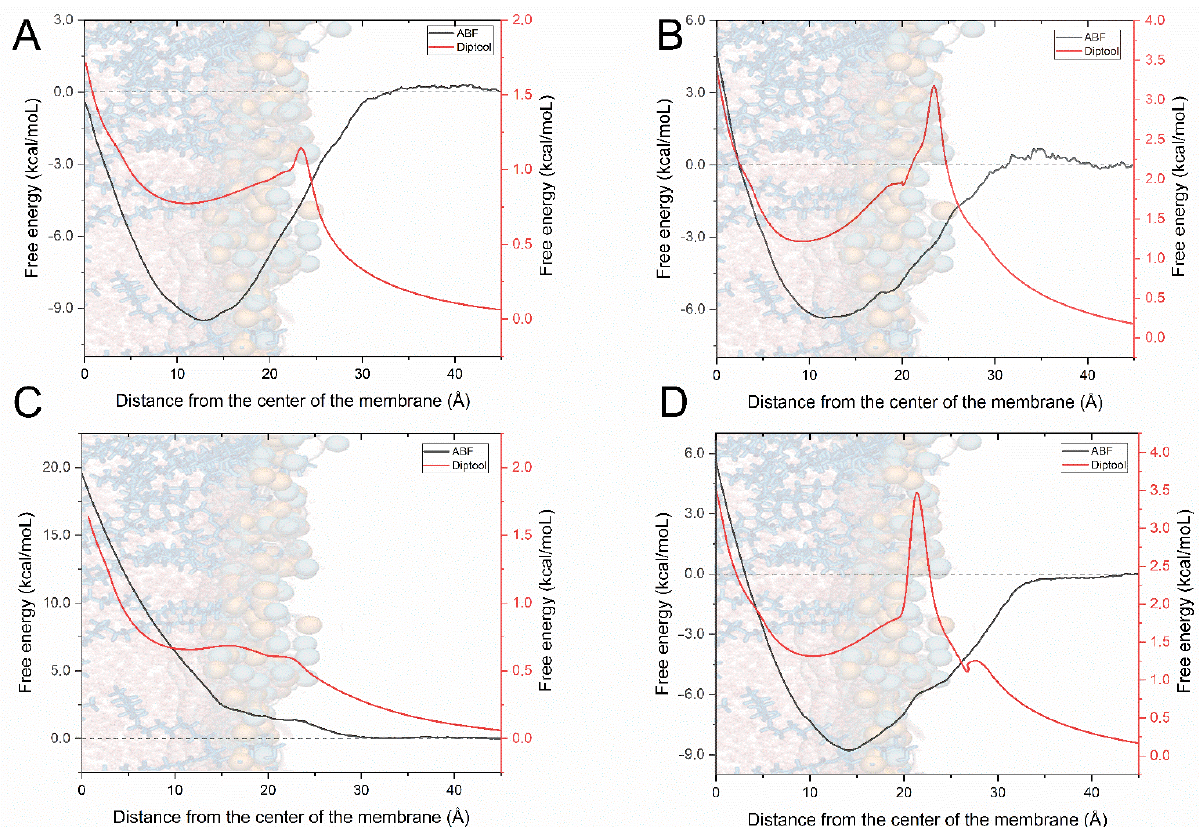
Figure 3. The comparison between MD − ABF and Diptool free energy calculation, marked in black and red, respectively. ( A ) Free energy transfer for OCT in PC membrane, ( B ) Free energy transfer for OCT in PG membrane, ( C ) Free energy transfer for CHX in PC membrane, ( D ) Free energy transfer for CHX in PG membrane.